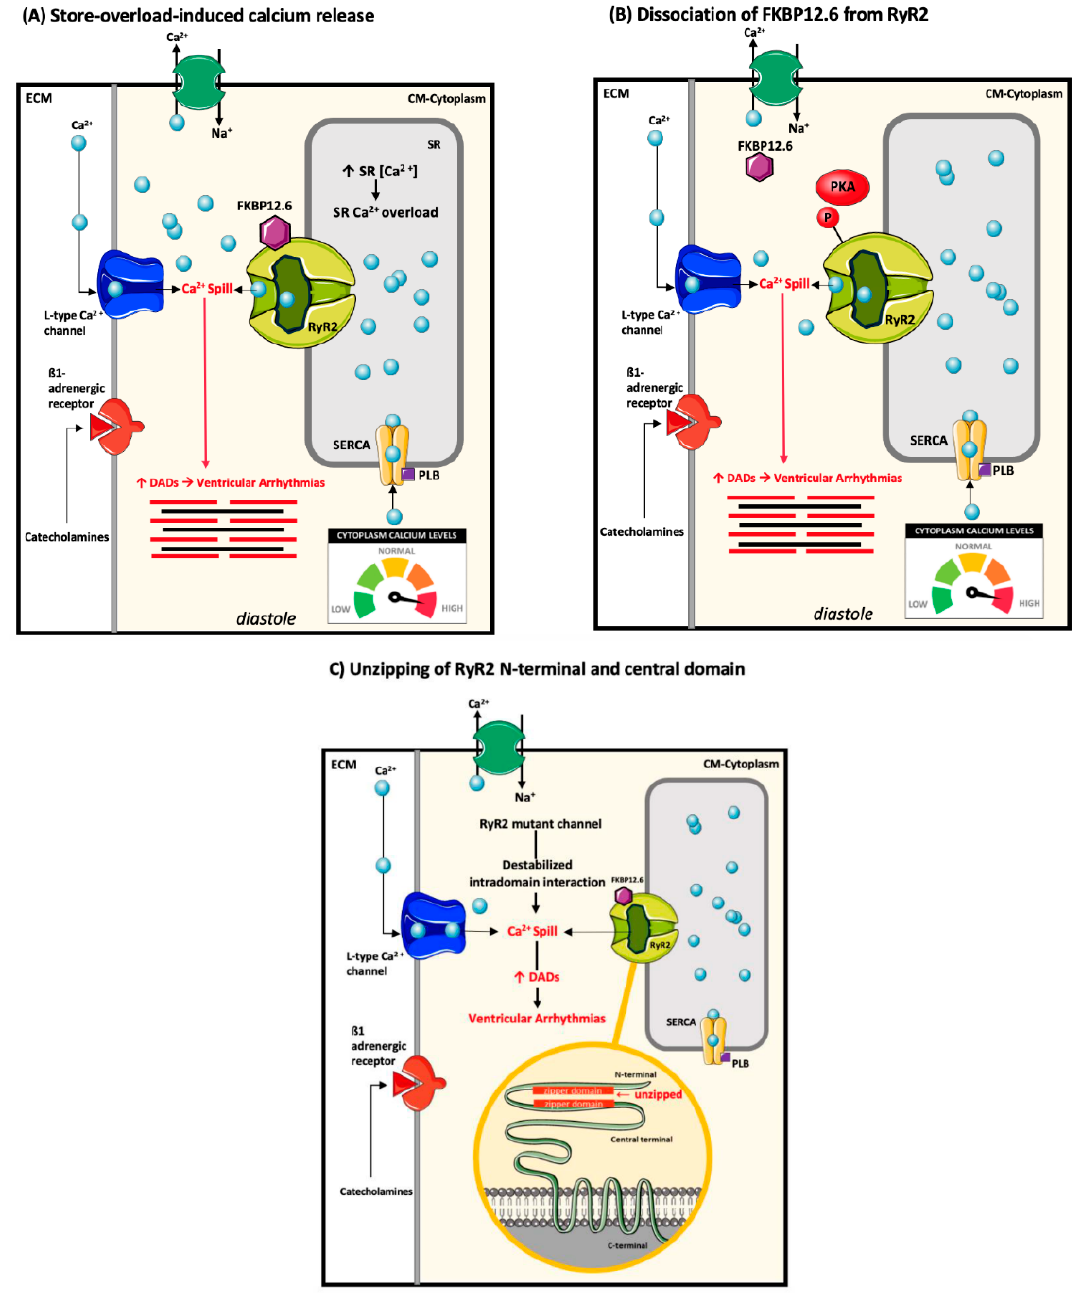
Figure 3. Proposed mechanisms of RYR2 -associated CPVT arrhythmogenesis: ( A ) Store overload-induced Ca 2+ release: RyR2 mutant channels may exhibit an increased sensitivity to the luminal Ca 2+ in the SR by decreasing the threshold needed to activate it, leading to increased Ca 2+ release from the SR during diastole. This leads to delayed afterdepolarizations (DADs) and thus, uncoordinated activation of cardiac tissue and triggered ventricular arrhythmias. ( B ) FKBP12.6 dissociation from the RyR2-complex: FKBP12.6 is phosphorylated by protein kinase A, leading to its dissociation from mutant RyR2, increasing diastolic Ca 2+ release and consequent contractility. ( C ) Unzipping of the N-terminal and central terminal of the RyR2 protein: N-terminal and the central domain of wildtype RyR2 interact to form a tight intramolecular structure or a “zip” to stabilize the channel. However, RyR2 mutant channels cause weak intramolecular domain interaction resulting in Ca 2+ spill. P= phosphate group; Other abbreviations as indicated in Figure 2. Image adapted from Wleklinski, M. J., Kannankeril, P. J., and Knollmann, B. C. (2020). The Journal of Physiology , 598 (14), 2817–2834 [60].